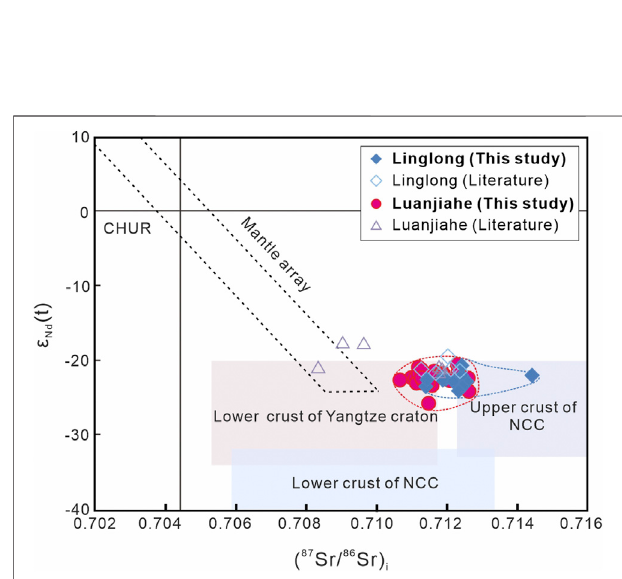
FIGURE10 | ( 87 Sr/ 86 Sr) i vs ε Nd (t) diagram for theLinglong and Luanjiahe granite.Datasources:theliteraturedataarefromYangetal.(2012);upperand lower crust of the NCC and the Yangtze Craton from Jahn et al. (1999). All the ( 87 Sr/ 86 Sr) i and ε Nd (t) values are calculated using the Chondrite Uniform Reservoir (CHUR) valuesof 87 Rb/ 86 Sr =0.0847and 87 Sr/ 86 Sr =0.7045 ( λ Rb = 1.42 × 10 – 11 year − 1 ), and 147 Sm/ 144 Nd = 0.1967 and 143 Nd/ 144 Nd = 0.512638 ( λ Sm = 6.54 × 10 – 12 year − 1 ; Lugmair and Marti,